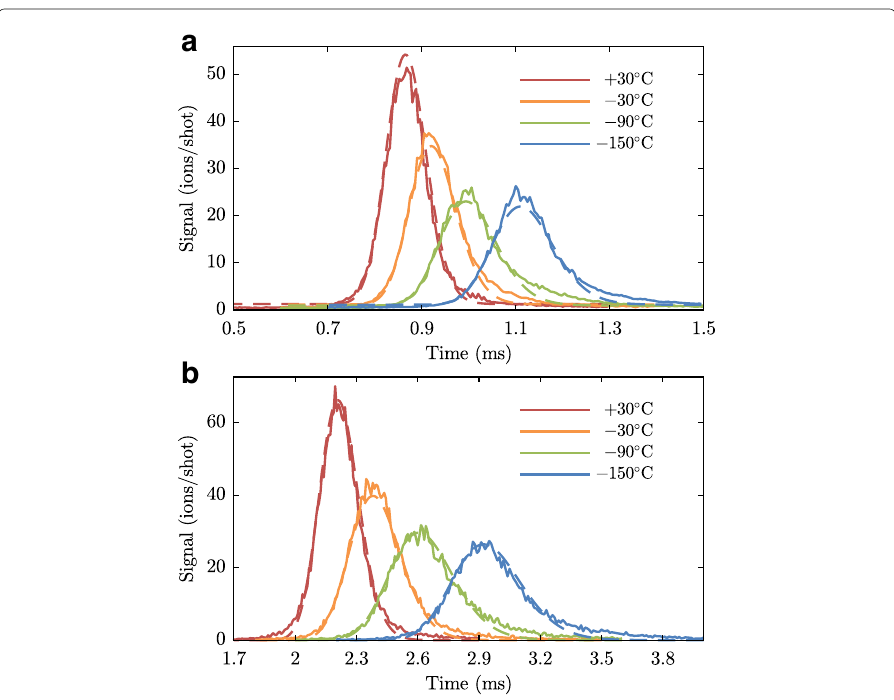
Fig. 7 Argon time-of-flights as measured in detection zones I ( a ) and II ( b ), at different temperatures of the pulsed valve. For each temperature, the two time-of-flight measurements are fitted simultaneously using the model discussed in the text. The parameters resulting from the fits are listed in Table 1